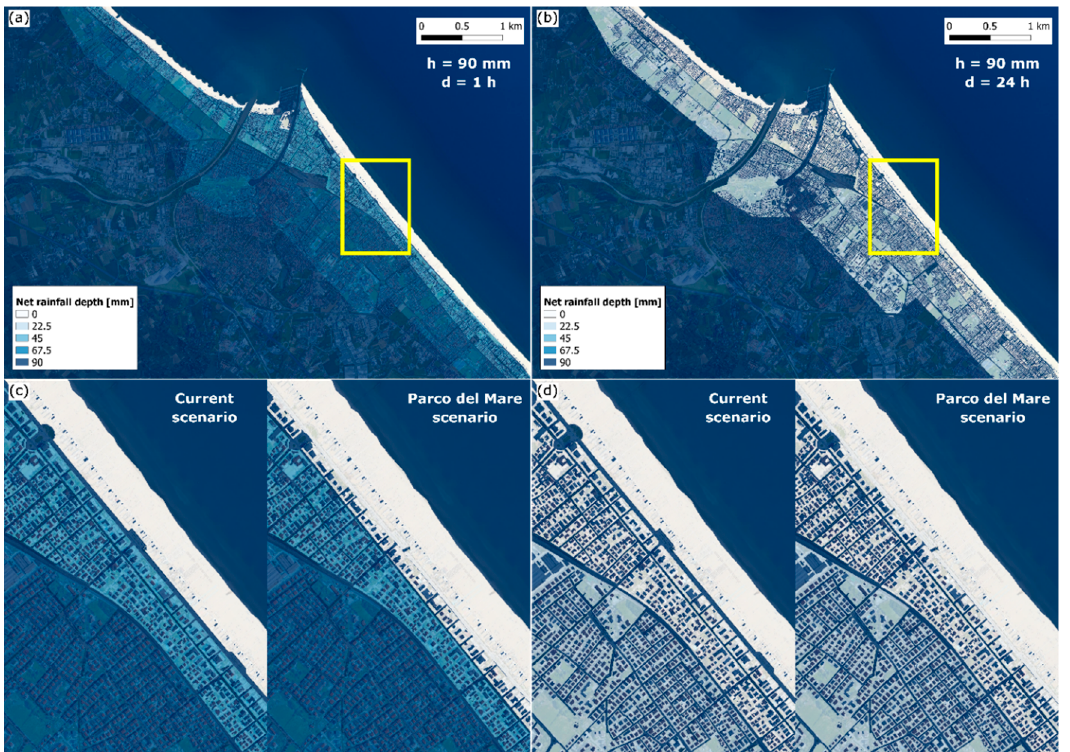
Figure 9. Rimini case study: rainfall events used for assessing the effectiveness of Parco del Mare urban green-infrastructure. ( a , b ) Spatially variable net-rainfall maps relative to the current land-use scenario and to two uniformly-distributed events having same rainfall depth (i.e., 90 mm) but different duration, ( a ) 1 h (return period of ~300 years), and ( b ) 24 h (return period of ~3 years), and spatially variable infiltration losses (see also Section 2.2). For the area identified by the yellow boxes, panels ( c ) and ( d ) compare the net-rainfall maps for the current and Parco del Mare land-use scenarios and for the 1-h and 24-h events, respectively.